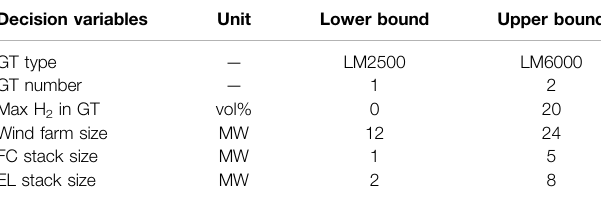
TABLE 1 | Input parameters for the optimization problem. Decision